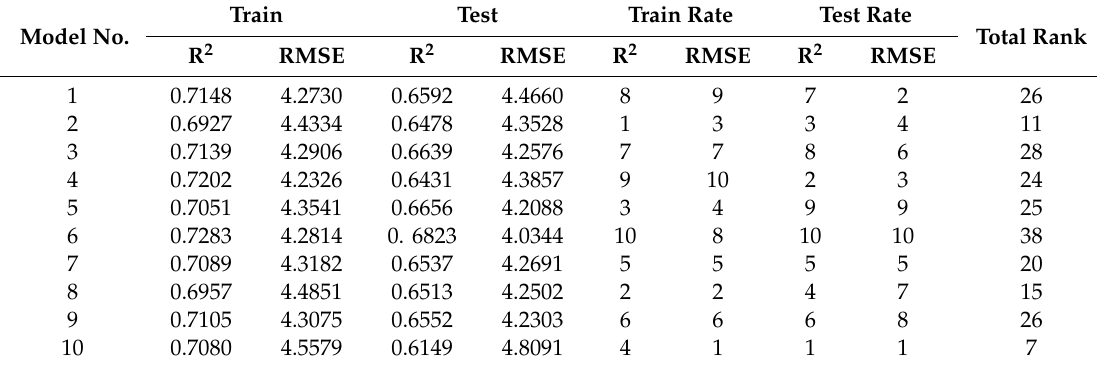
Total Rank Total Rank